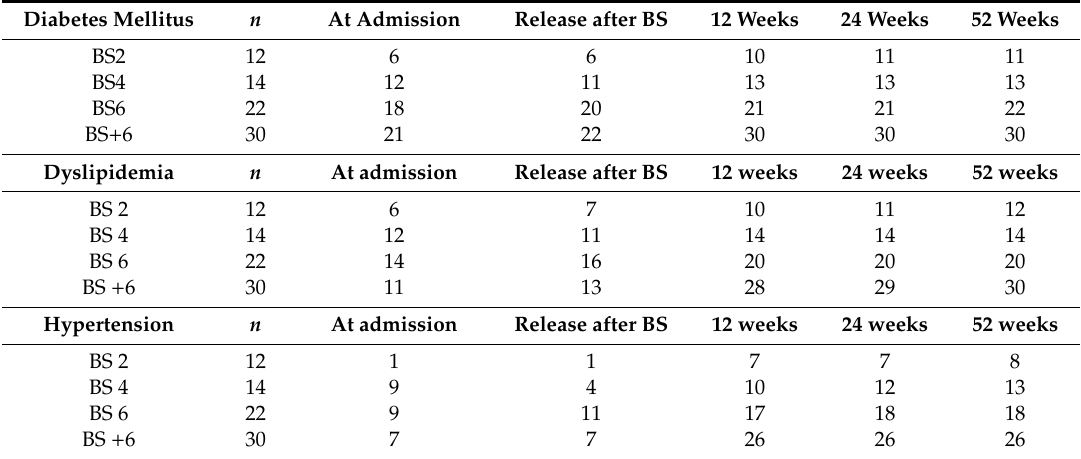
Table 5. Frequency of comorbidities (diabetes, dyslipidemia, and hypertension) over time in the groups, according to the ACRO score ( ≤